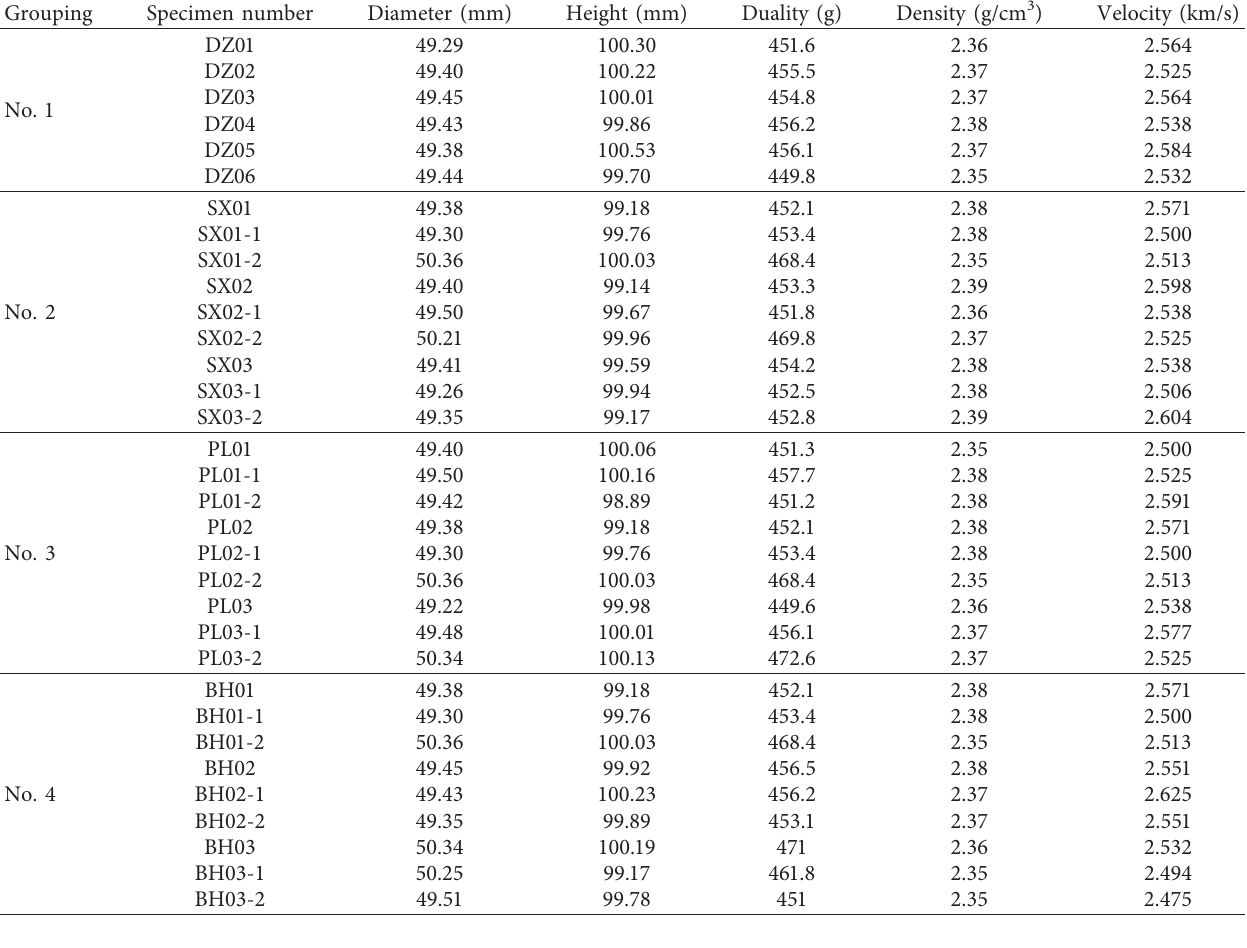
Table 1: Grouping of test pieces.